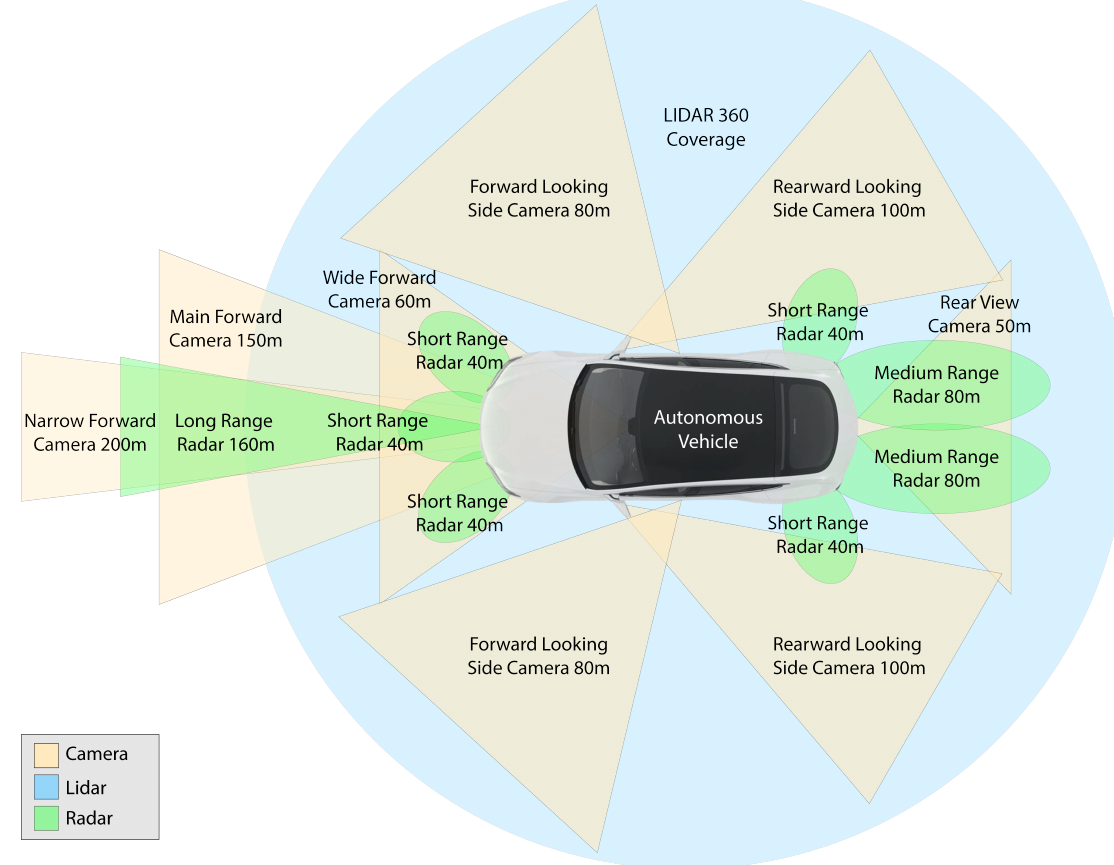
Figure 2. Surround sensors used for environment perception in autonomous vehicles. Their placement on the vehicle, coverage, and maximum range is shown. Green areas show radars coverage (long-range, medium-range and short-range), orange areas show camera coverage around the car, blue indicates LiDAR 360-degree